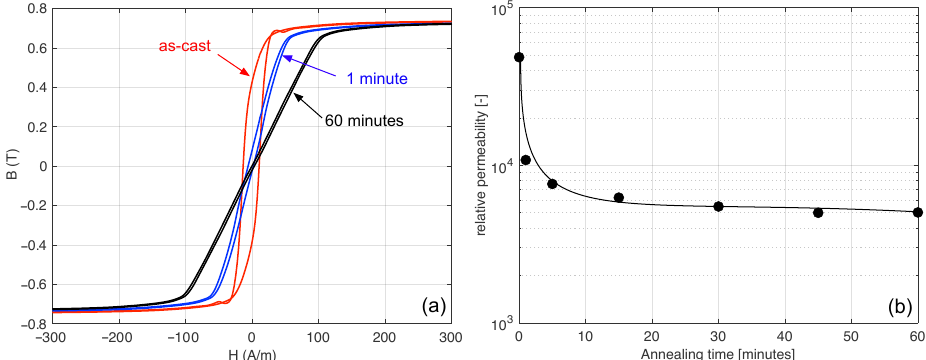
Figure 2. Axial B-H loop of Unitika AC20 wires in its as-cast form and for 1 min and 60 min annealing ( a ) and the corresponding axial relative permeability ( b